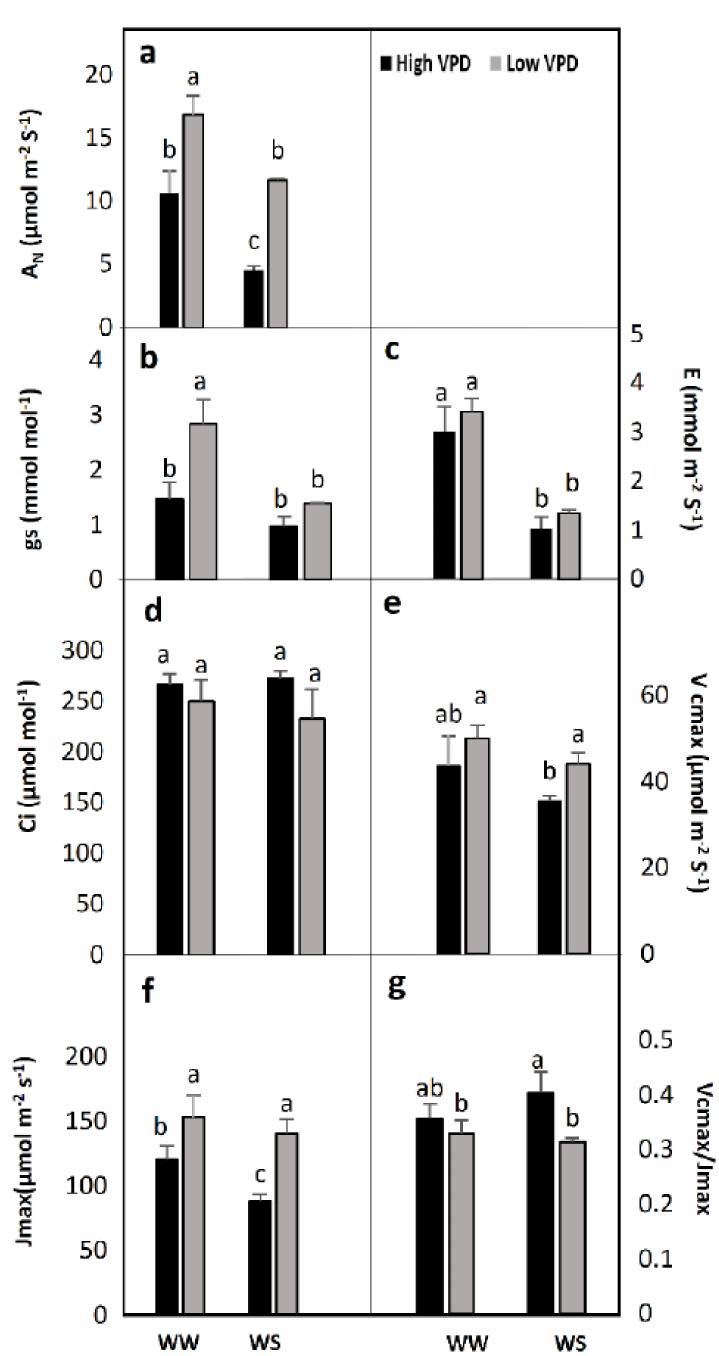
Figure 2. Effect of water irrigation (pot capacity-WW- versus 50% of pot capacity-WS) and ambient vapour pressure deficit (VPD; high 40 % RH versus low 80% RH) on ( a ) net photosynthesis (AN), ( b ) leaf conductance (gs), ( c ) transpiration (E), ( d ) intercellular CO 2 concentration (Ci), ( e ), Rubisco maximum carboxylation capacity (Vcmax) ( f ) maximum rate of electron transport (Jmax) and (g) the Vcmax/ Jmax rate ( g ) determined on wheat flag leaves. Each value represents the mean ± se of four replications. Statistical analysis was made by a two-factor ANOVA. Different letters above the columns indicate significant differences ( p < 0.05) between treatments as determined by LSD